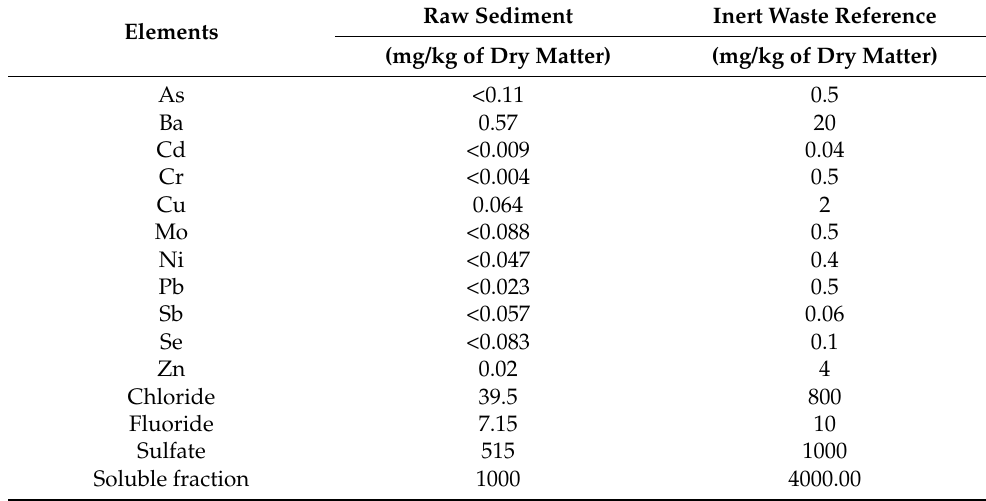
Table 4. Water leaching test results for raw sediments and inert wastes.